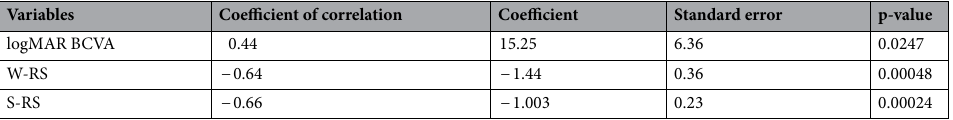
Table 5. Result of univariate analysis between the total SRD area (SRDa) and retinal sensitivities. logMAR BCVA logarithm of minimum angle of resolution of best-corrected visual acuity, W-RS mean overall